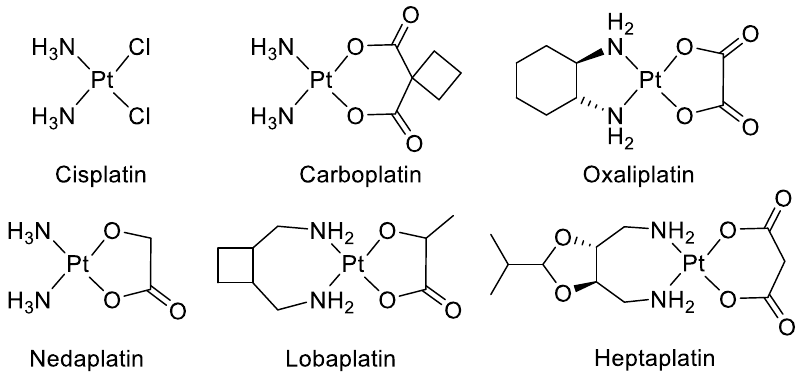
Figure 1. Platinum (II) complexes.